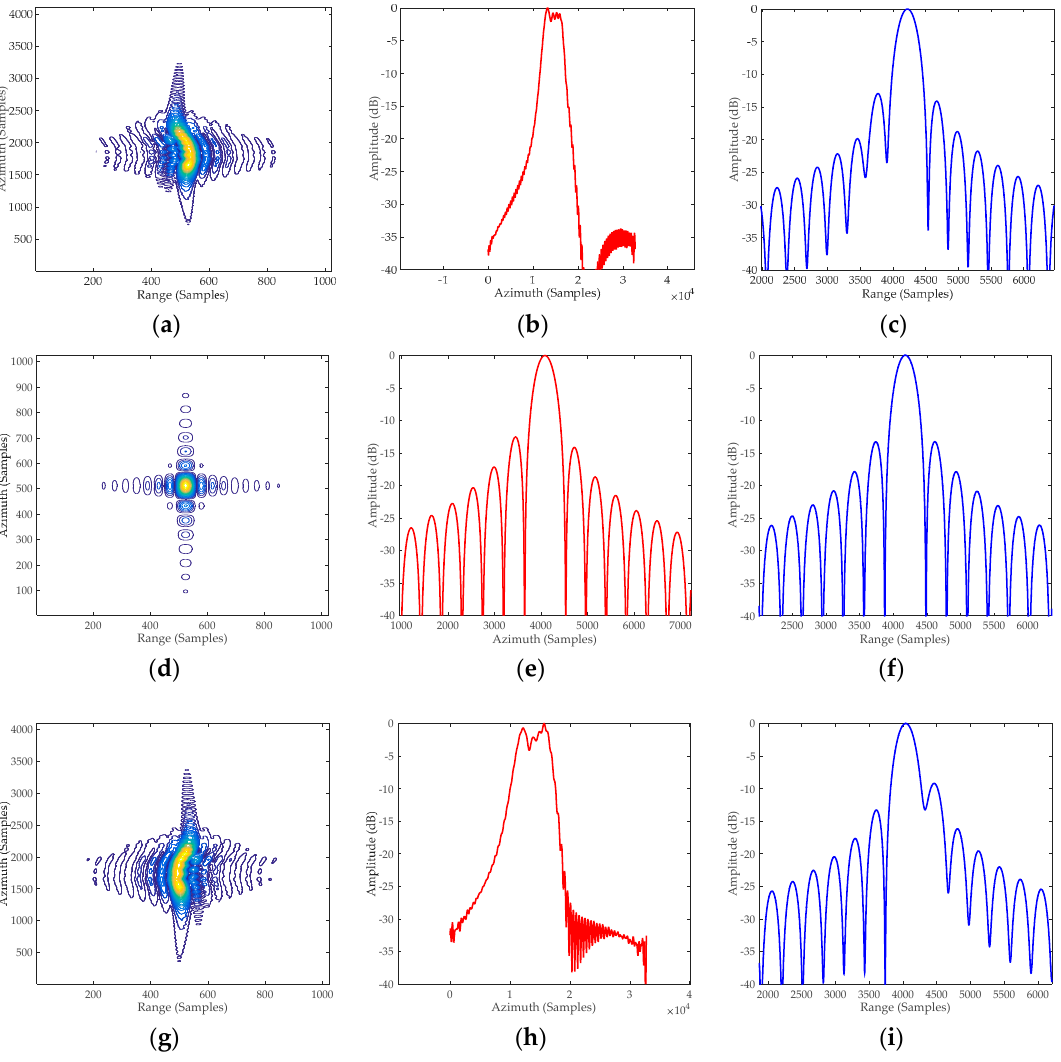
Figure 16. Imaging results of the 2D nonlinear chirp scaling (CS) algorithm [18]. The first ( a , b , c ), second ( d , e , f ), and third ( g , h , i ) row correspond respectively to points T 1 , T 2 , and T 3 illustrated in Figure 15. The first ( a , d , g ), second ( b , e , h ), and third ( c , f , i ) column represent contour maps, azimuth profiles, and range profiles, respectively. Table 3. Evaluation of imaging quality (in position